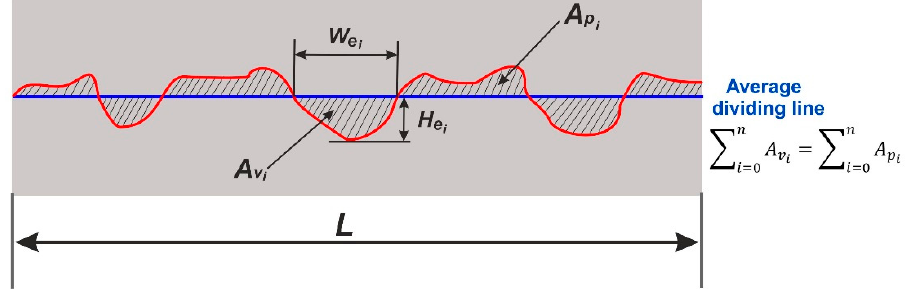
Figure 7. Sample profile of the depth and width of grain embedment (valleys) along the measurement section in the selected area, on the surface of the fracture face.